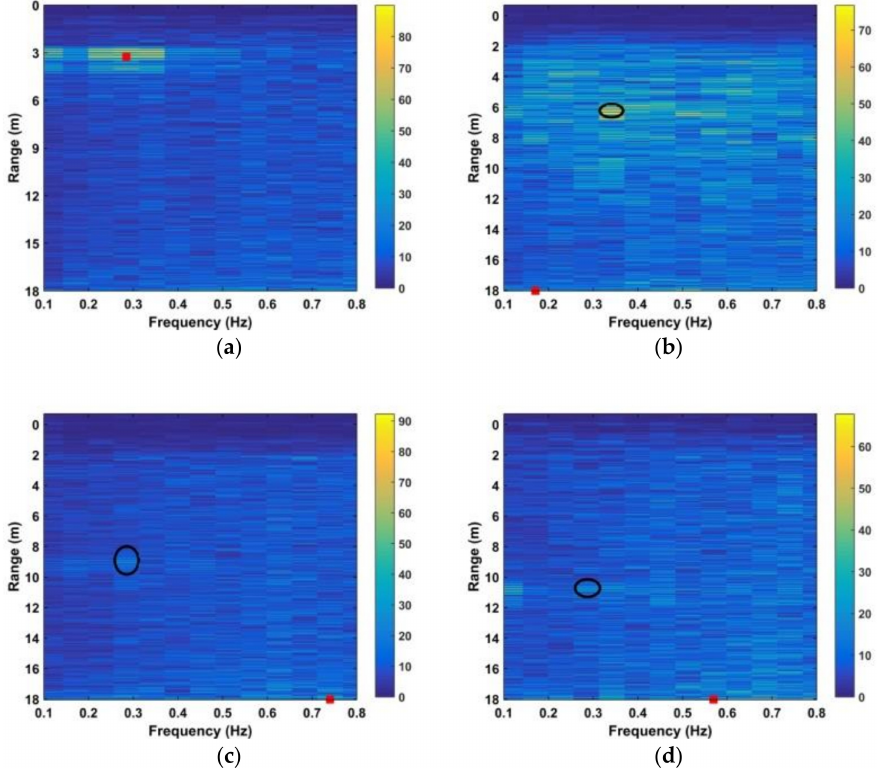
Figure 16. Results using the AM method with a human subject at distances between the antenna and human subject of ( a ) 300 cm, ( b ) 600 cm, ( c ) 900 cm, and ( d ) 1100